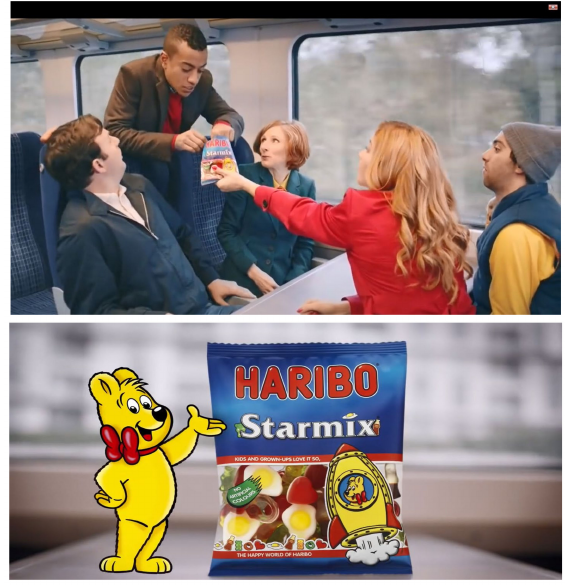
Figure 2. Still images from Haribo’s train advert (from https: // www.youtube.com / watch?v =